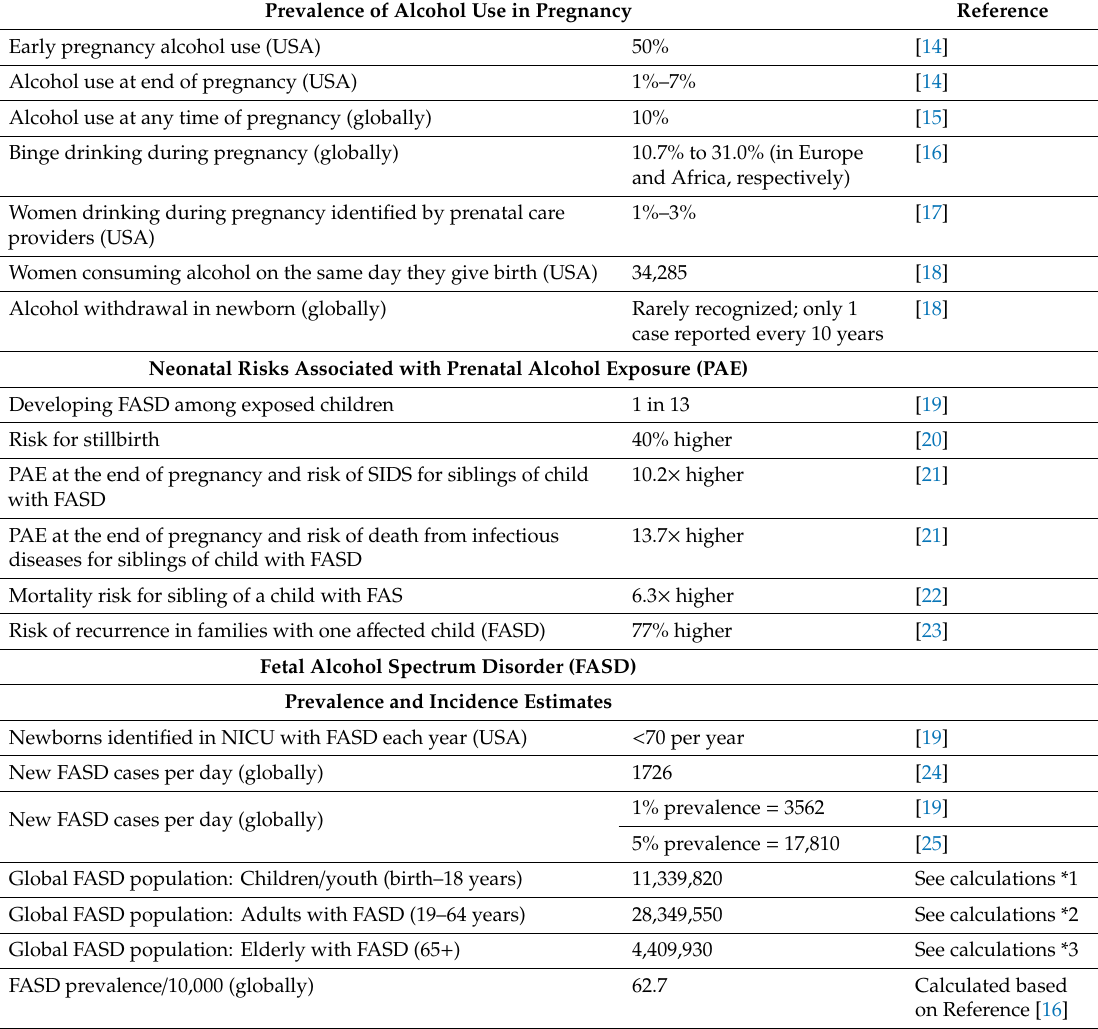
Table 1. Fetal alcohol spectrum disorders (FASD): A 2019 Fact